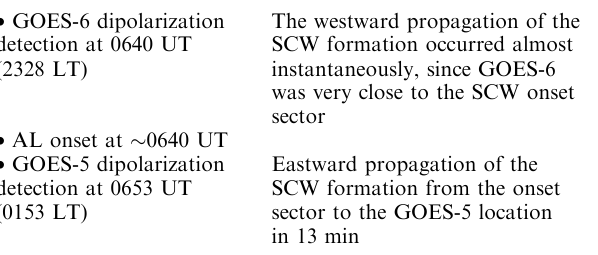
Table 5. The overview of the substorm that occurred on May 7, 1986, between 0600 and 0900